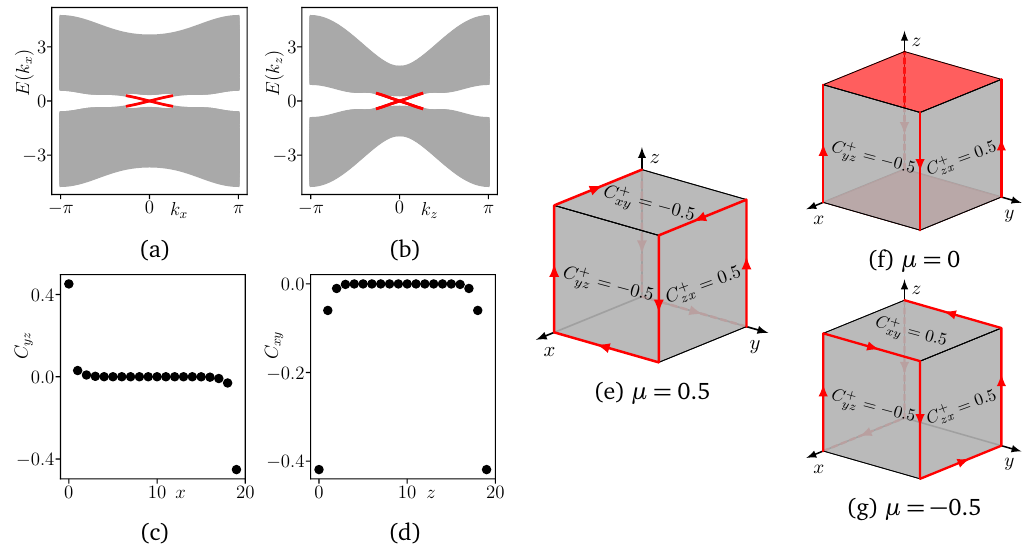
Figure 4: Panels (a-b) show the result of exact diagonalization of the Hamiltonian in Eq. (61) with µ > 0 and open boundary conditions in two directions with system size 15 × 15 and periodic boundary condition in the third direction. Panels (c-d) shows the result of the layer resolved Chern number for the case when µ > 0. Panels (e-g) shows the profile of the Majorana chiral hinge modes for different values of the chemical